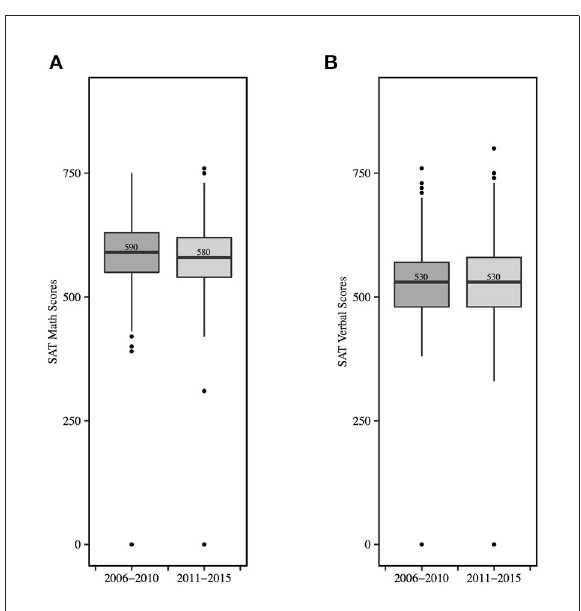
FIGURE3 The comparison of the (A) SAT math scores, and (B) SAT verbal scores of the high-risk students from Fall 2006–2010 and the high-risk students from Fall 2010–2015. The t -tests yielded p -value > 0.05 in both cases, indicating no statistically significant difference between the two